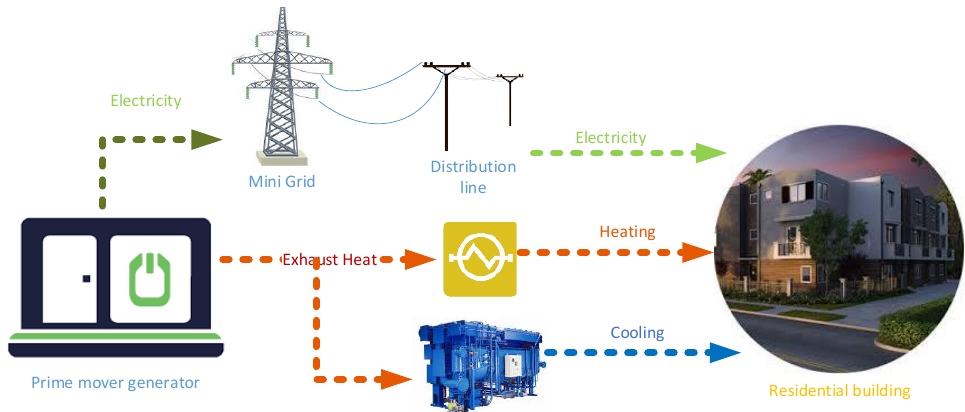
Figure 2. Integrated energy supply design for residential application .